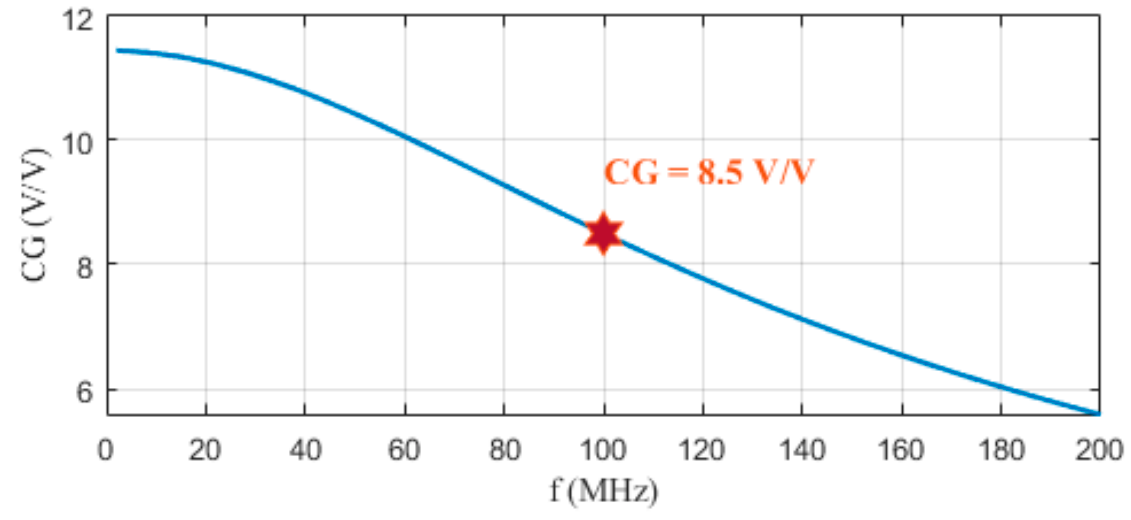
Figure 10. Mixer conversion gain versus the intermediate-frequency f IF .